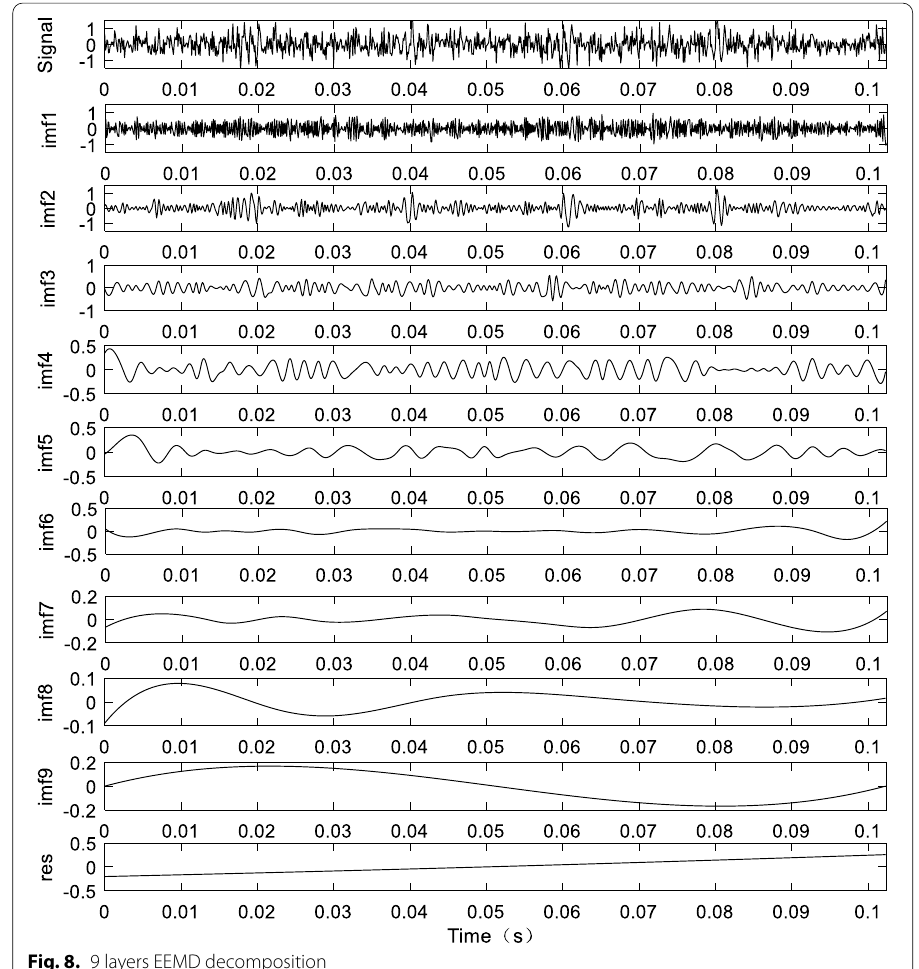
Fig. 8. 9 layers EEMD